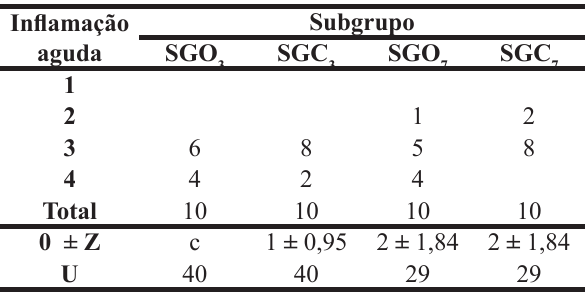
FIGURA 3 - Inflamação aguda moderada no SGC7 TABELA 2 – Intensidade da inflamação aguda nos animais dos subgrupos controle e Orbignya , analisada nos 3º e 7º dias do período pós-operatório.